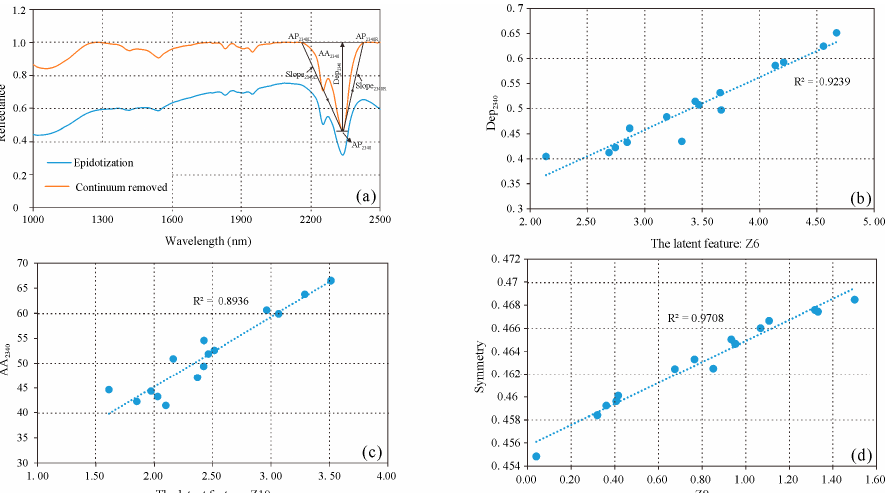
13 of 22 Figure 8. ( a ) The distribution of the original synthetic dataset; ( b ) the distribution of the latent vec- tors extracted from SSAAE; ( c ) the convergence process of reconstruction error on training and test- ing sets. Where the dimensionalities were reduced using PCA [56] and the different colors in ( a ) and ( b ) represent different categories. 1-Montmorillonite; 2-Chlorite; 3-Epidote; 4-Muscovite; 5-Quartz. In addition, we also established the relationship between latent features and spectral absorption features to indirectly illustrate the interpretability of latent features. Figure 9a shows the spectral absorption features of an epidotization alteration at the wavelength range of 2100–2430 nm, including absorption position, absorption depth, absorption area,